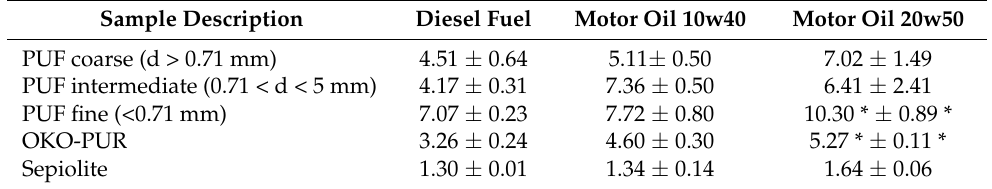
Table 2. Oil sorption capacities of the tested materials (values expressed in g of oil/g of sorbent). The results are expressed as mean of three replicates with related standard